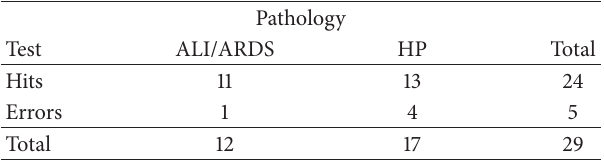
Table 1: Confirming the accuracy of the groupings. True and false pathologies checked by the ROC curves from the predictive criteria ∗ on the 7th DAI and the causa mortis